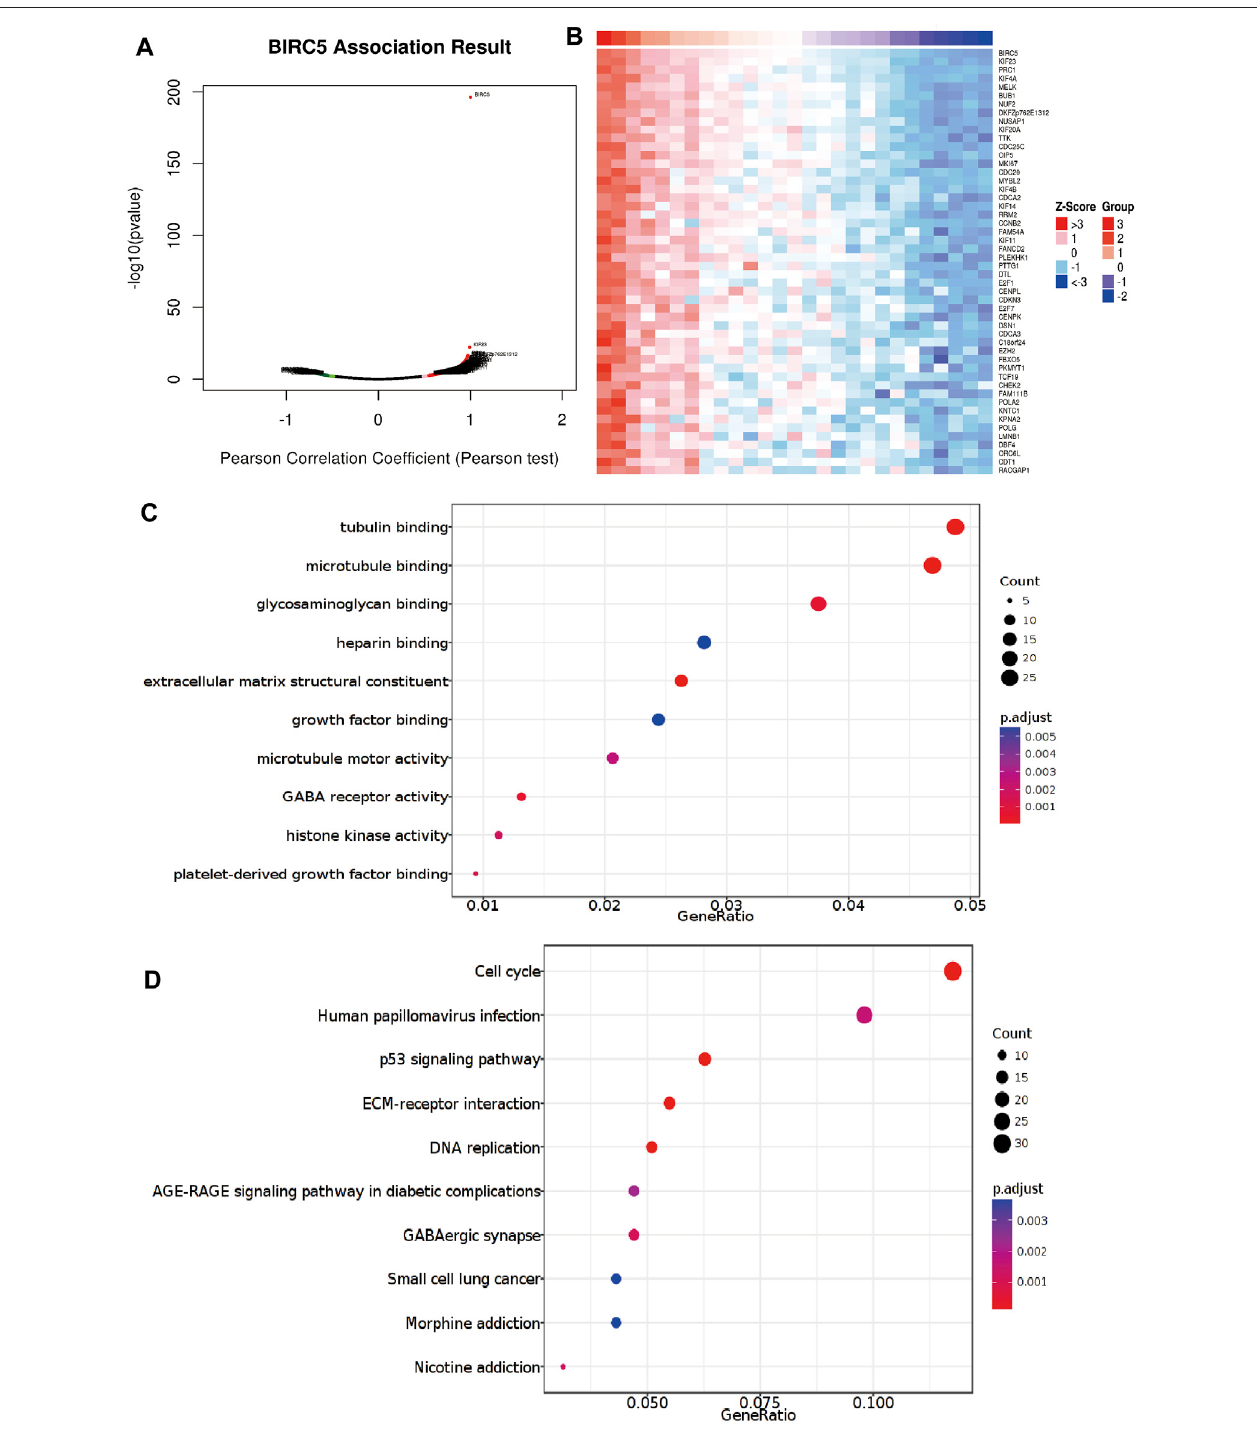
FIGURE 6 | Analysis of the function of BIRC5 expression in LGG. (A,B) Analysis of the co-expression gene of BIRC5 in LGG examines by linkomics database. (C) Analysis of the molecular function of BIRC5 in LGG. (D) Analysis of the KEGG signaling pathway of BIRC5 in LGG.